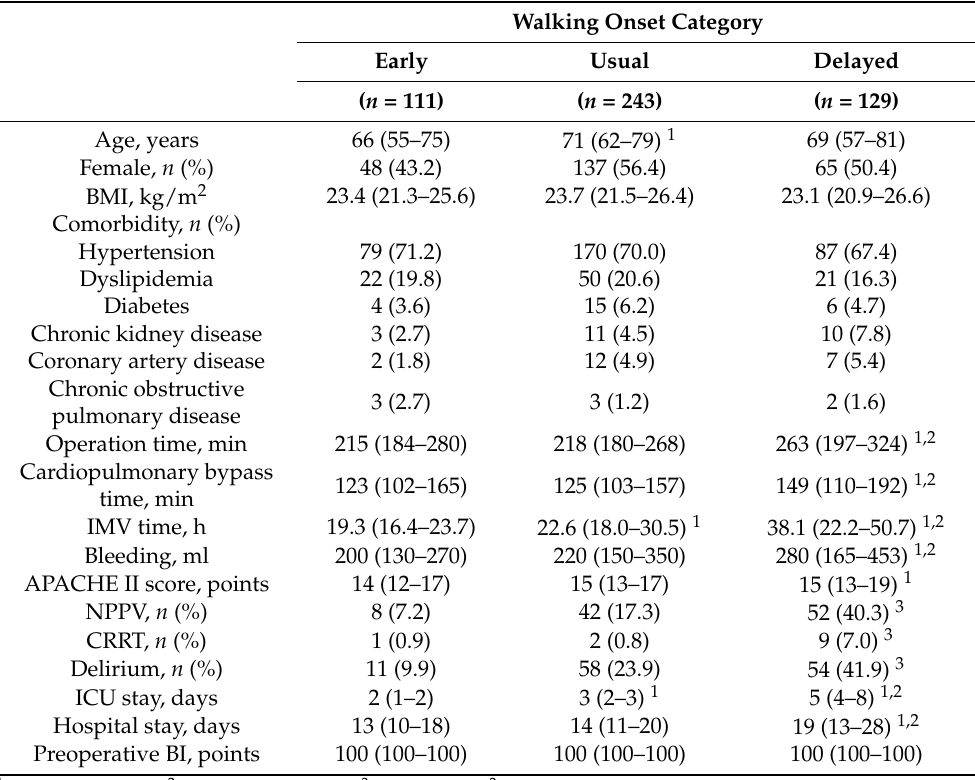
Table 4. Univariate and multivariate analyses for hospitalisation-associated disability.